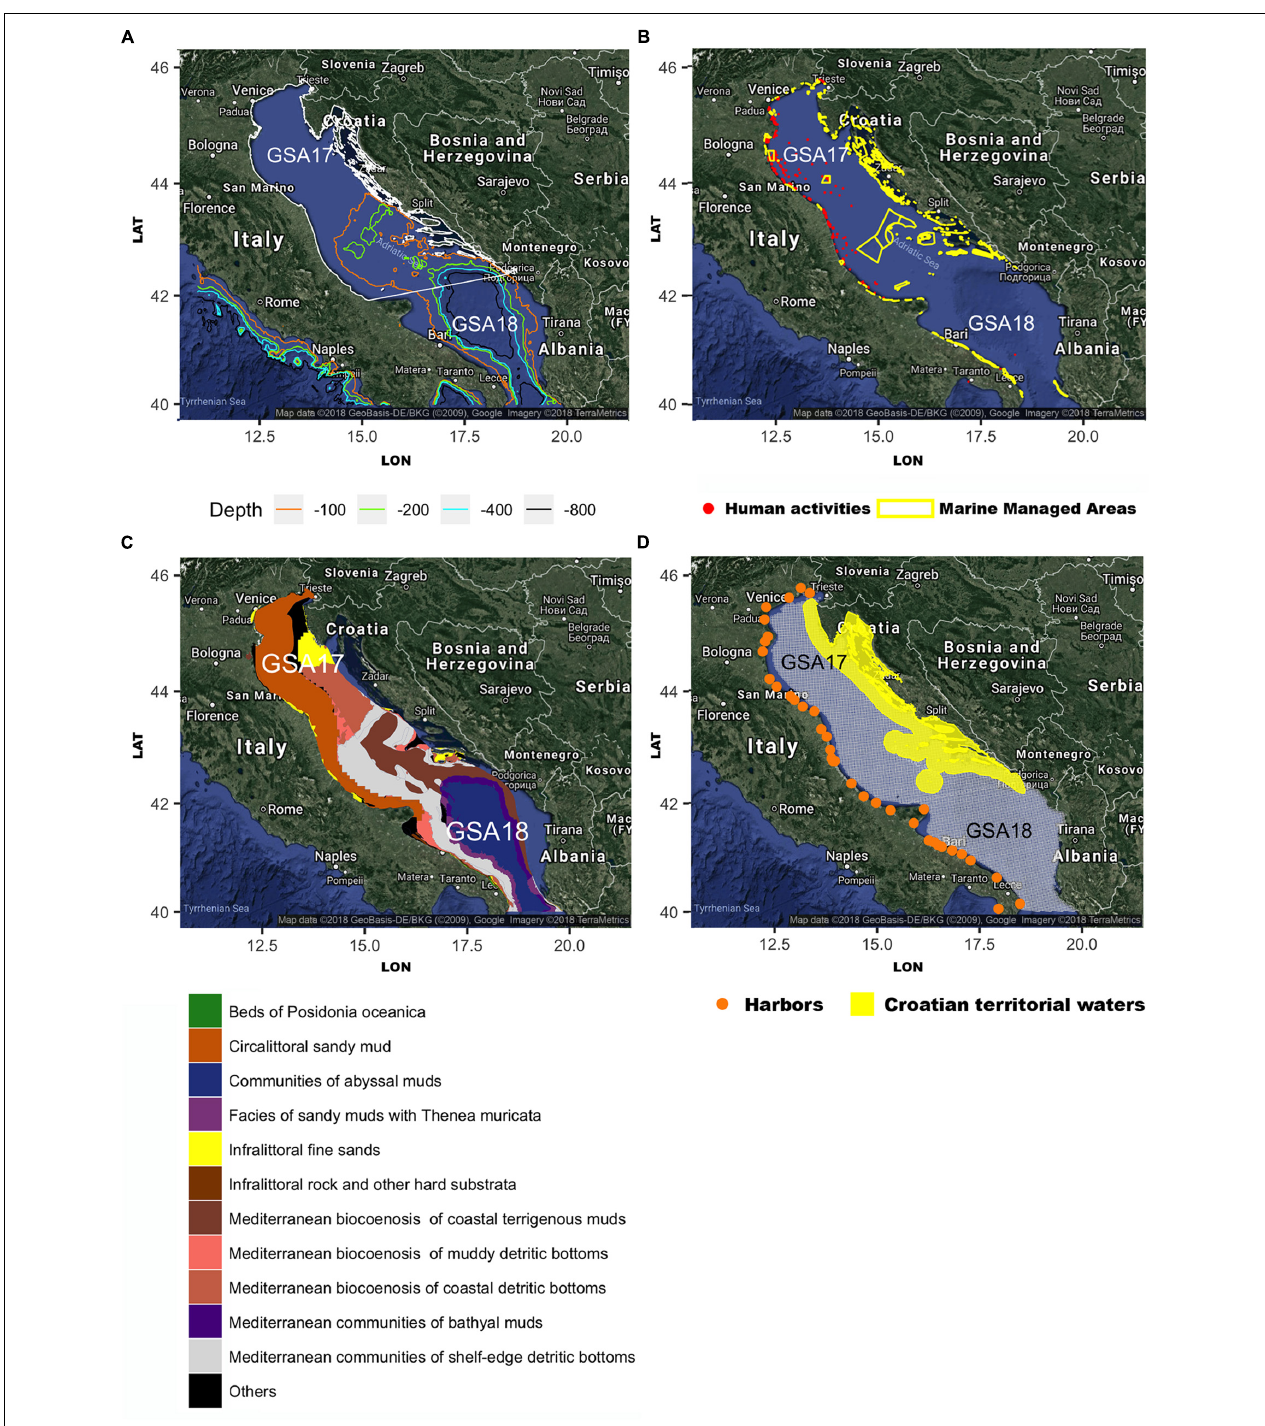
FIGURE 2 | (A) Study area: the Adriatic Sea with the two FAO Geographical Sub Areas (GSAs) (white lines) and the main isobaths are shown; (B) human activities (in red) and marine managed areas (in yellow); (C) main bottom substrates obtained from the European Marine Observation Data Network (EMODnet) Seabed Habitats project (http://www.emodnet-seabedhabitats.eu/); and (D) the 3 × 3 km square grid (in gray) used within the DCF for the computations of the fishing pressure indicators; the Croatian territorial waters are excluded from the analysis. The figures were created using the R package ggmap (Kahle and Wickham, 2013) importing images from Google